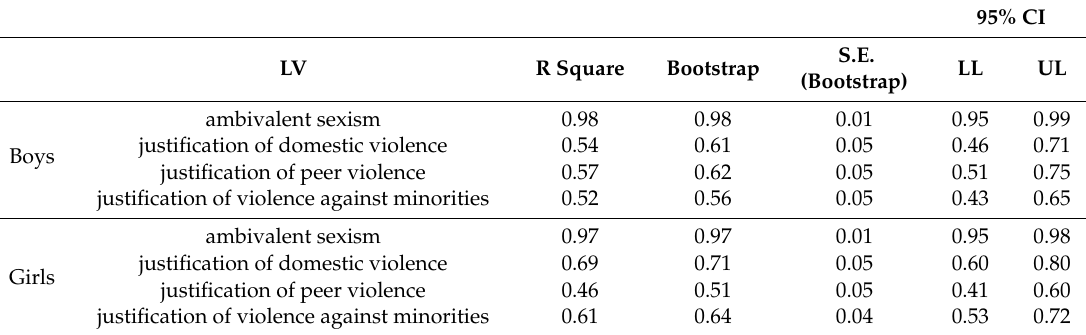
Table 2. R squares of latent variables—the mixed two step approach (boys and